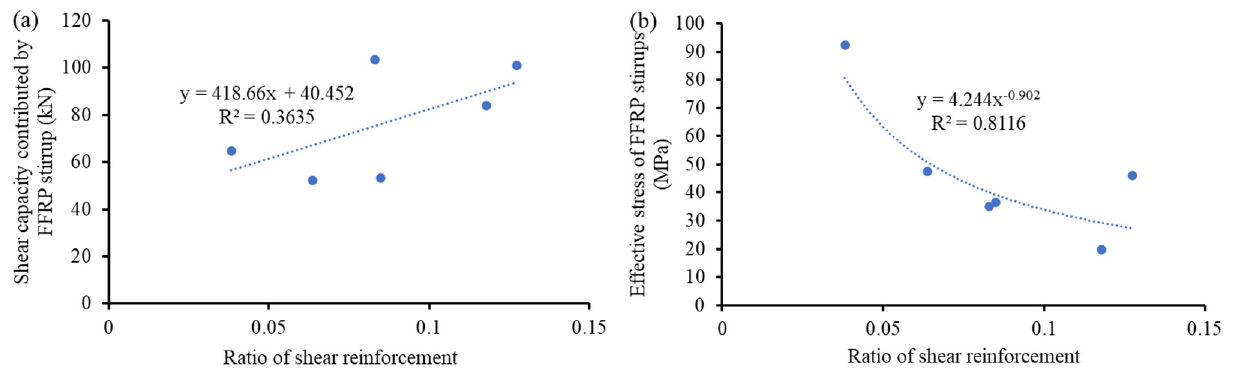
Figure 13. Behavior of FFRP stirrup: ( a ) shear capacity contribution and ( b ) effective stress.